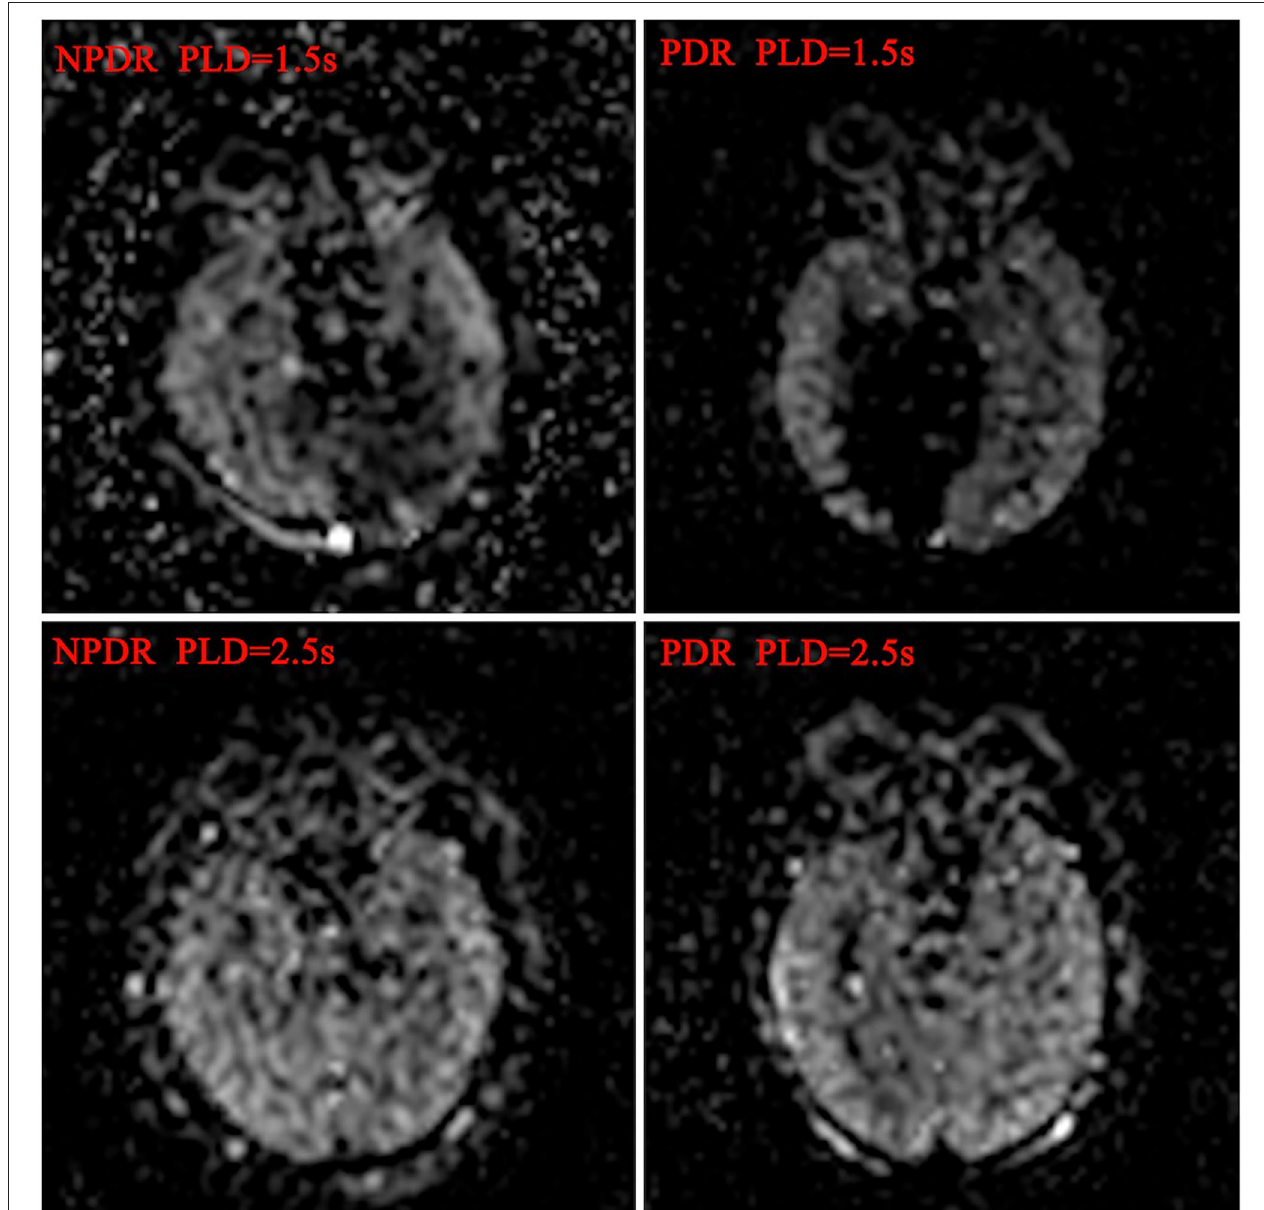
FIGURE 1 | Blood flow maps of ocular and cerebral in DR patients. The ocular and cerebral blood flow maps was automatically derived from the ASL images at postlabeling delay 1.5 and 2.5s, respectively.